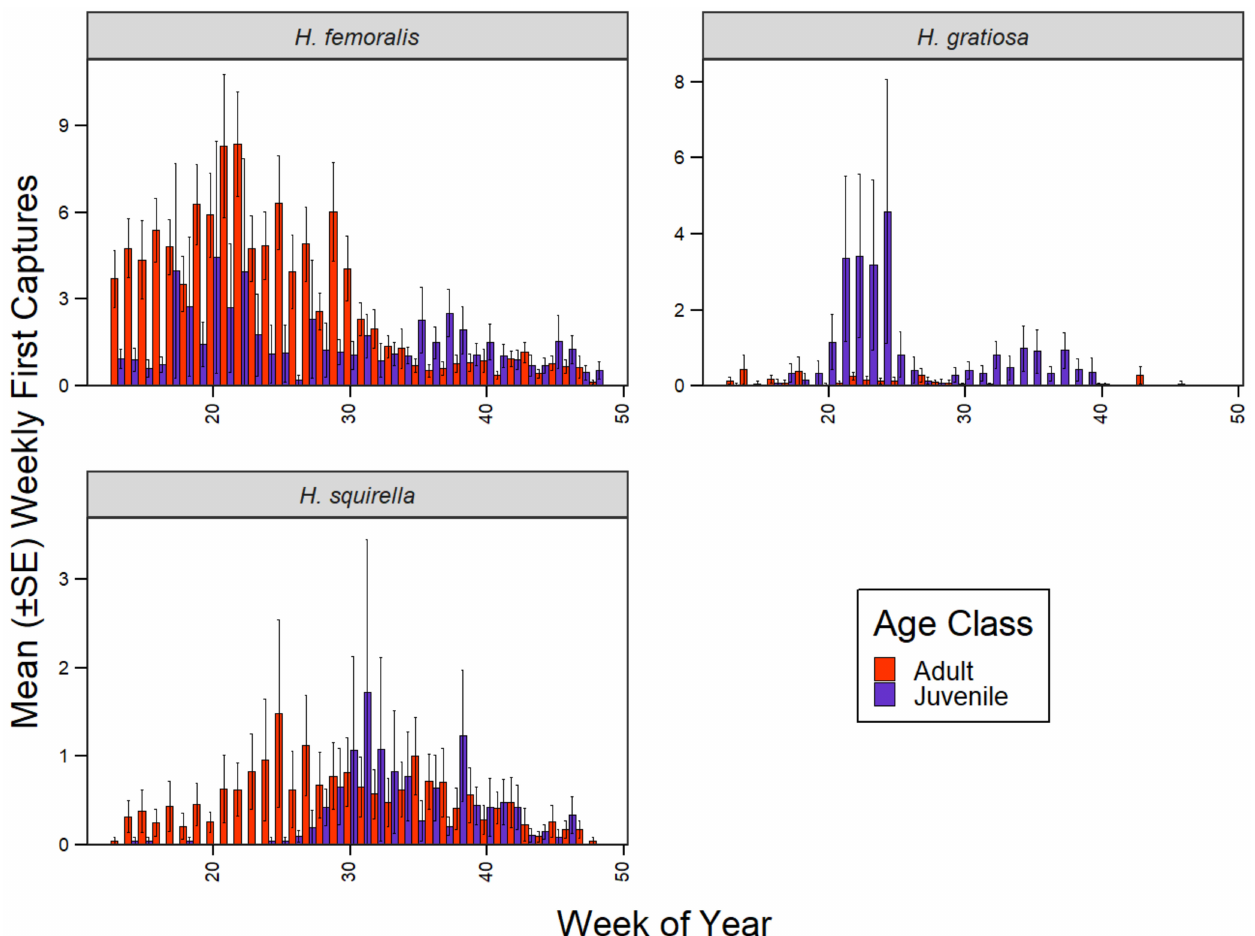
Figure 3. Mean (+/ − SE) weekly (1994–2017) first captures of adults and juveniles of Hyla femoralis , H. squirella , and H. gratiosa , Ocala National Forest, Marion County, Florida. Hyla femoralis and H. squirella used PVC pipes as refugia year-round; we assumed that spikes in adult captures reflected adult breeding